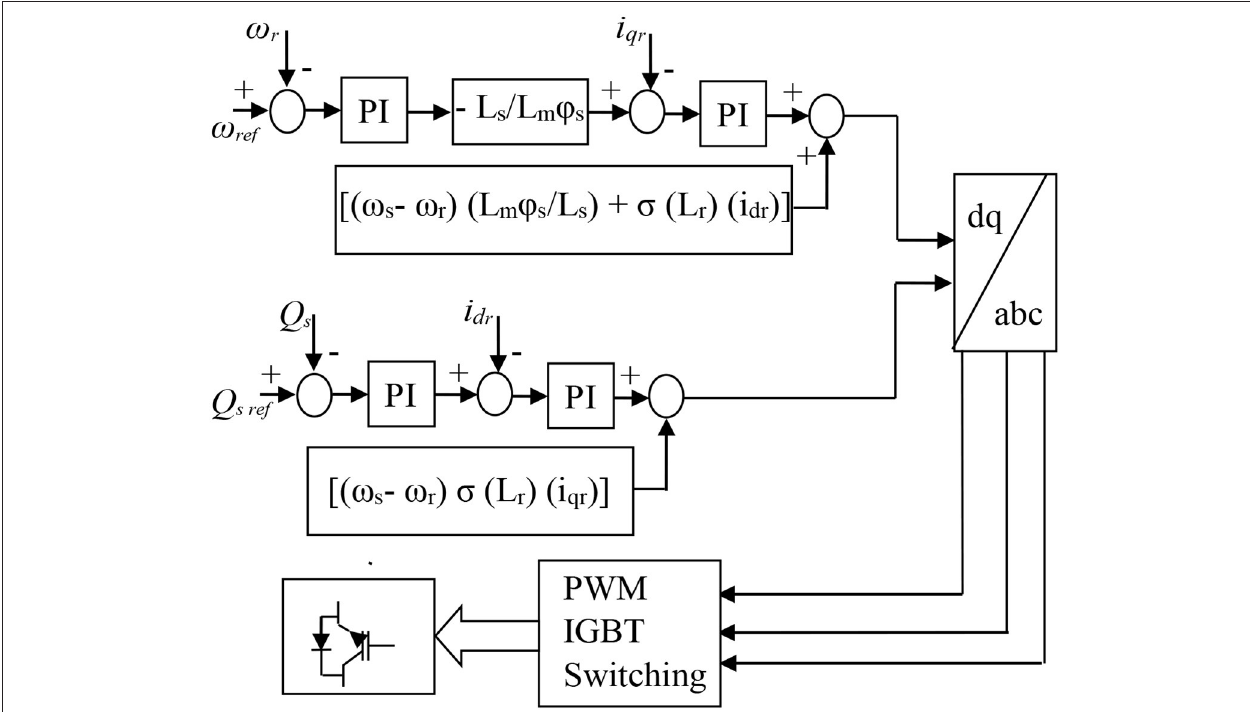
FIGURE 3 | The rotor side converter control circuit of the DFIG.